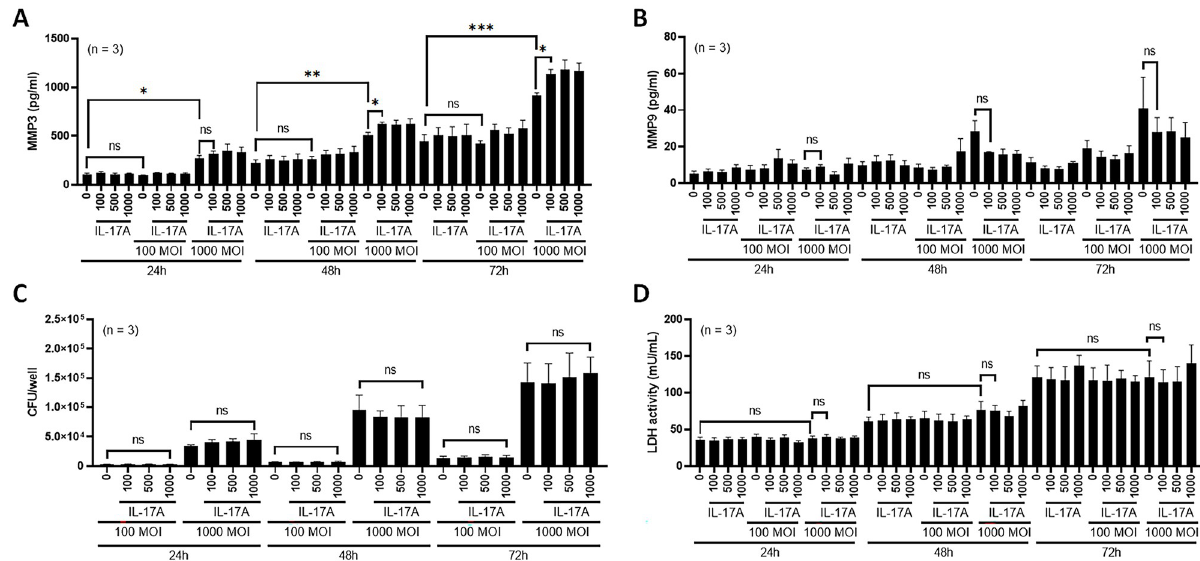
Fig 7. Effects of IL-17A on M . intracellulare -infected human lung epithelial cells. ( A-D ) The human lung epithelial cell line H1975 was infected with different bacterial numbers [0, 100 and 1000 multiplicity of infection (MOI)] in the presence of different concentrations of IL-17A (0, 100, 500 and 1000 ng/ml). MMP-3 (A), MMP-9 (B), bacterial burden (C) and lactate dehydrogenase (LDH) activity (D) were evaluated at the indicated time points. MMP-3 (A), MMP-9 (B) and LDH activity (D) were evaluated in cell culture supernatants, and bacterial burden (C) was determined in cell lysates. Data are expressed as the means ± SEM. � P < 0.05, �� P < 0.01, and ��� P < 0.001. ns, not significant. Three independent experiments were